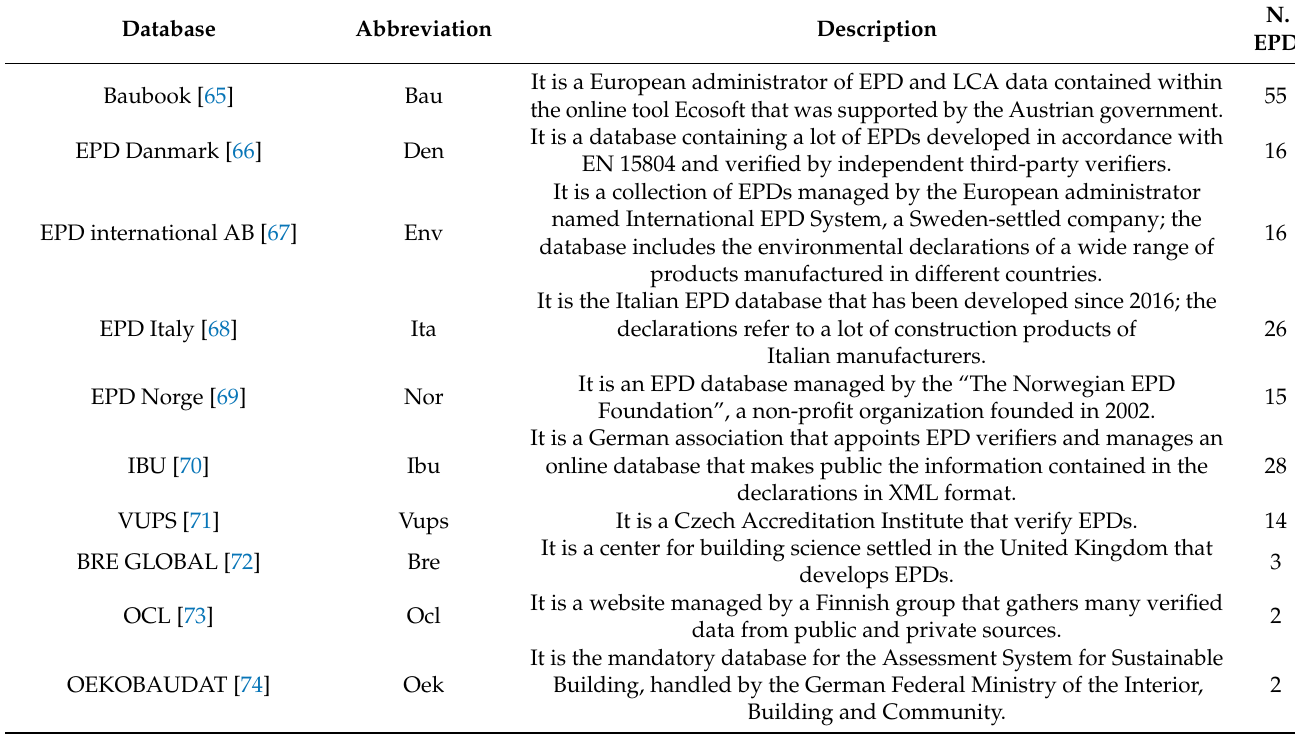
Table 3. Databases consulted for the present study